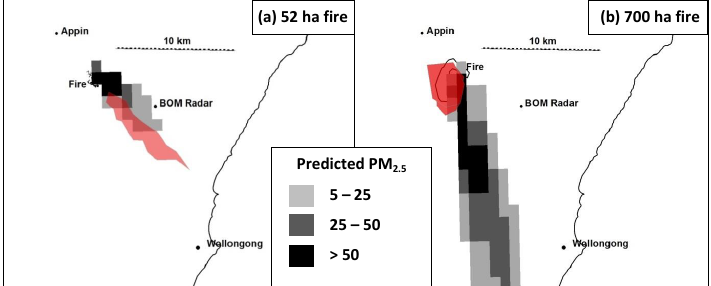
Figure 5. Smoke plumes for the each fire as observed from the 3-D radar data at noon and predicted surface PM 2 . 5 concentrations from the dispersion model. The pink shading is the outline recorded from the rain